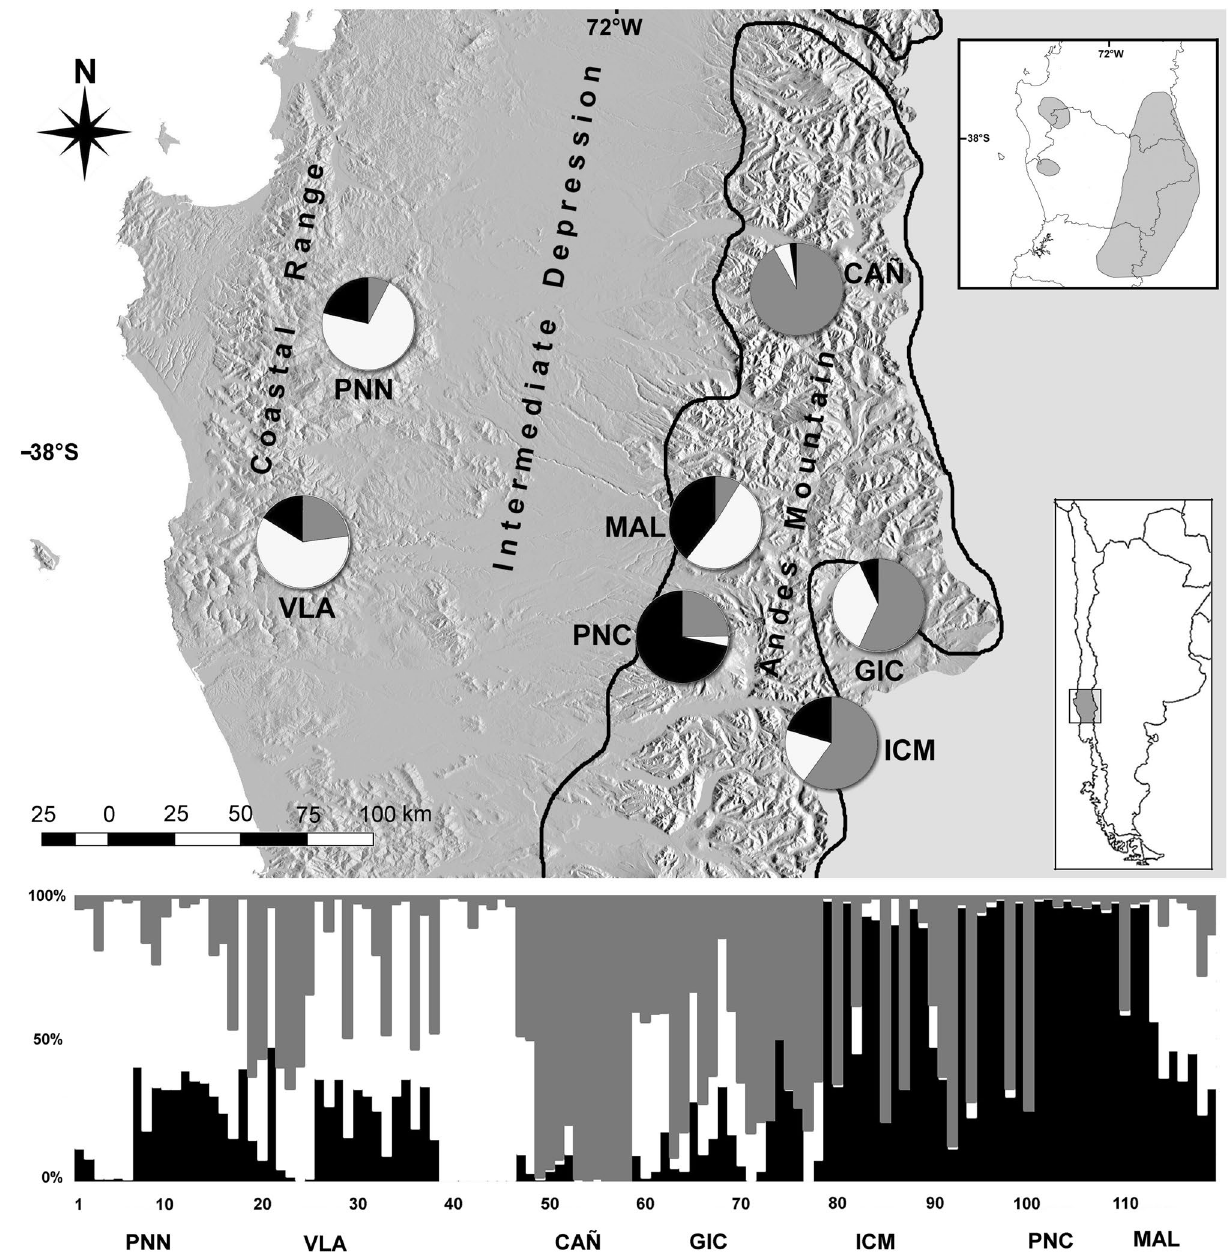
Figure 1. Distribution of collection sites of Araucaria araucana . Circles indicate the proportions of haplotypes in each site. Dark line indicates limit of the ice sheet during LGM 89 . Right-upper box shows the Araucaria araucana distribution 90 . Right-lower box shows the Chilean geographical context of studied sites. Below-barplot indicates the individual genetic composition of K = 3 genetic group. Map was made using free and Open Source Software licensed under the GPL inkscape v. 1 (https:// inksc ape. org/).